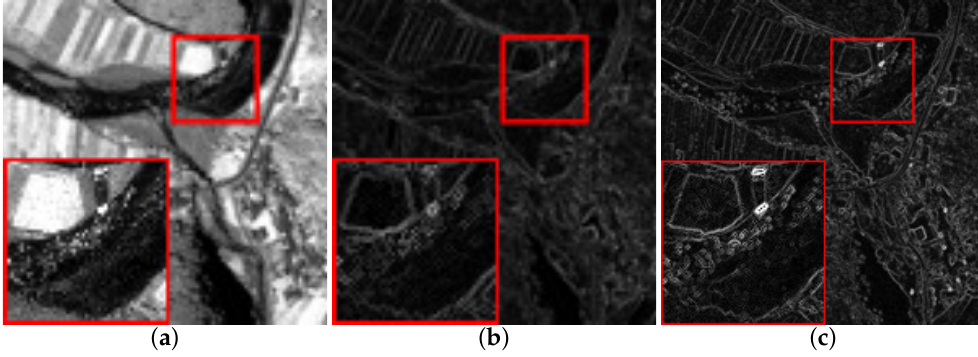
Figure 1. Panchromatic image and gradient maps. ( a ) PAN; ( b ) IAIHS; ( c )